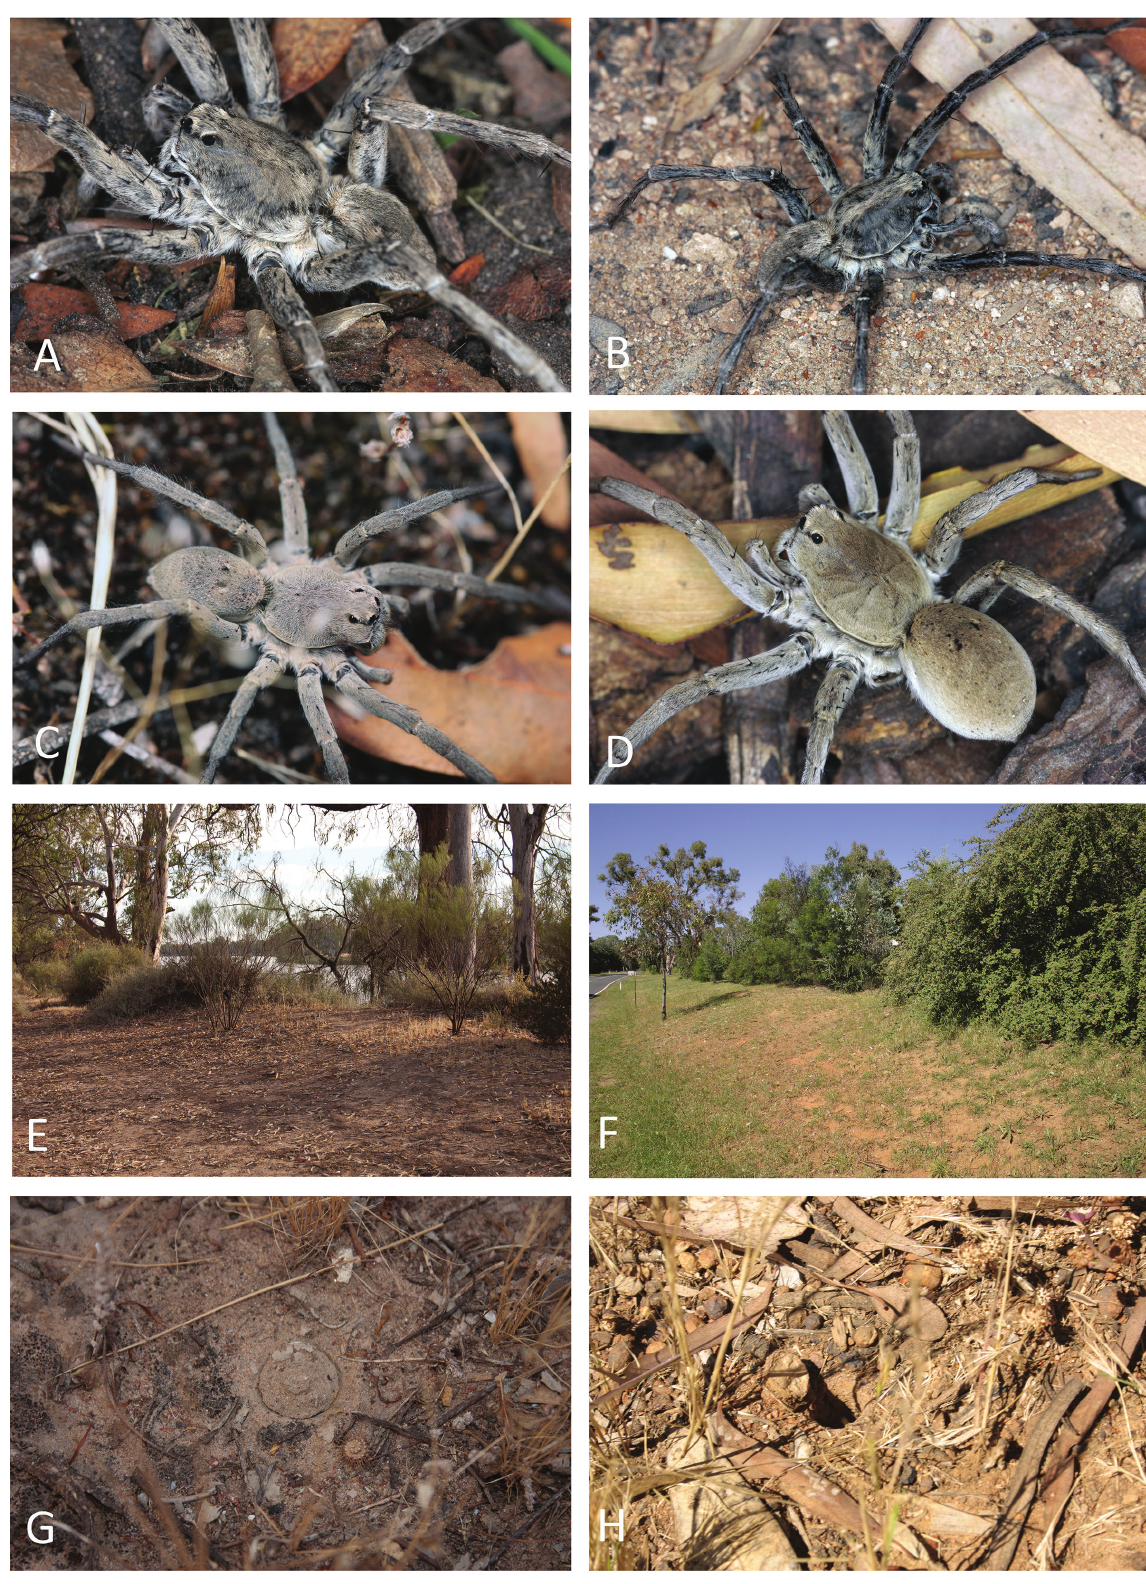
Figure 1. Live images and habitat of Portacosa cinerea gen. n. and sp. n. A , male holotype (WAM T68032) from near Apex Park, Mildura, Victoria. B, male, same locality. C, female (WAM T56062) from Specimen Hill Bushland Reserve, Bendigo, Victoria, D, female from Red Hill, Canberra, Australian Capital Territory (WAM T67906); E, open Eucalyptus camaldulensis riparian wood- land, near Apex Park, Mildura, Victoria, where the holotype male (WAM T68032) was found. F, road embankment in Red Hill, Canberra, habitat of female WAM T67906. G, closed burrow of holotype male (WAM T68032). H, open burrow of female WAM T67906 from Red Hill,